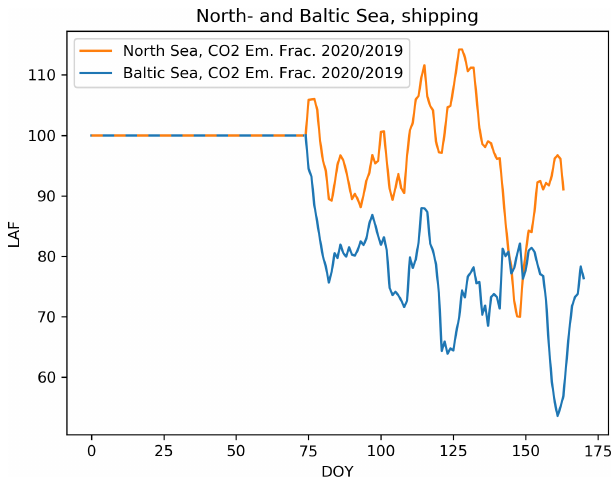
Figure 3. Lockdown adjustment factors created from the 7d rolling mean ratios of CO 2 emissions from shipping in 2020 relative to 2019. Until day 75 (15 March) no changes and a LAF of 1 was